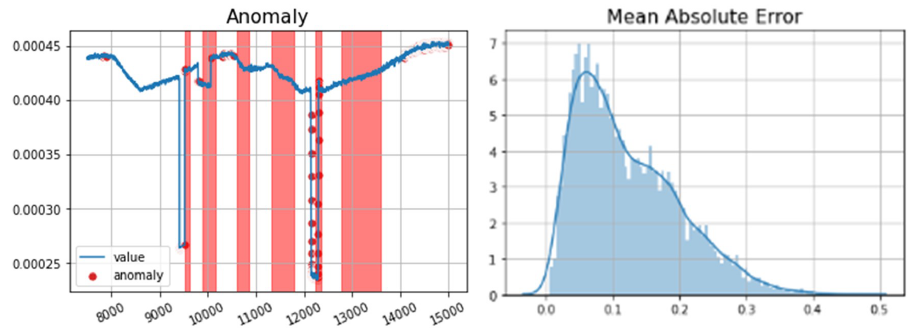
Figure 12. ( left ) FIT401-detected anomalies, ( right ) Anomaly detection